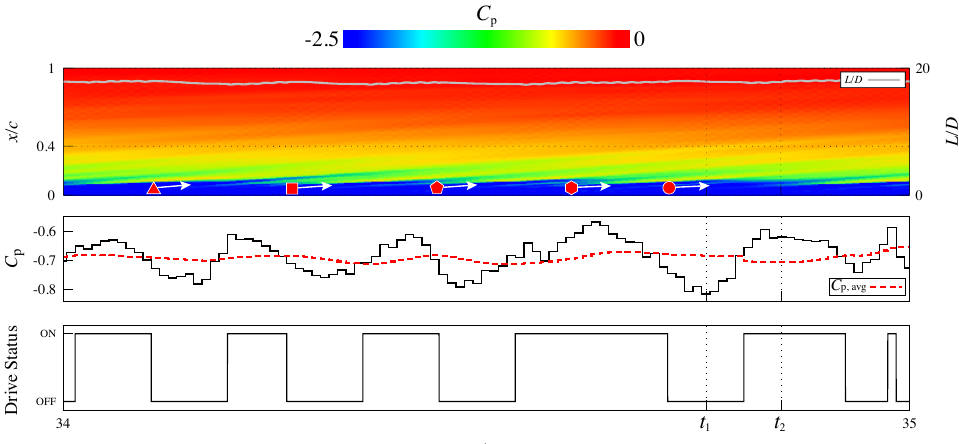
Figure 17. Time histories of L / D , C p at the pressure sensor, and the drive status of the plasma actuator in FTM1 from the top to bottom. The top figure overlaps with the distribution of the spanwise-averaged C p on the upper surface of the airfoil in the x / c - t domain. The red symbols and arrows represent the characteristic vortex positions and their